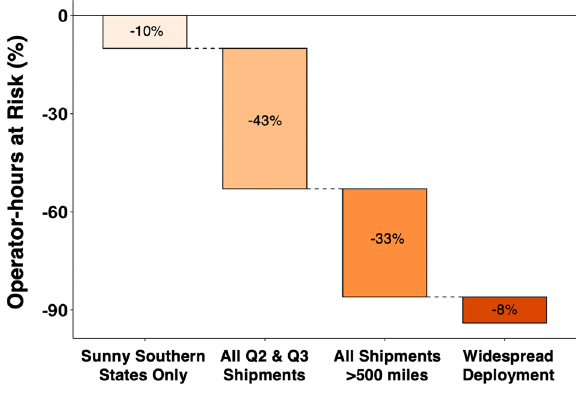
Fig. 3 The impact on operator-hours as each deployment scenario becomes feasible, cumulatively building on the previous deployment. Starting with only a 10% impact on operator-hours, automation can eventually put 94% of current long haul operator-hours